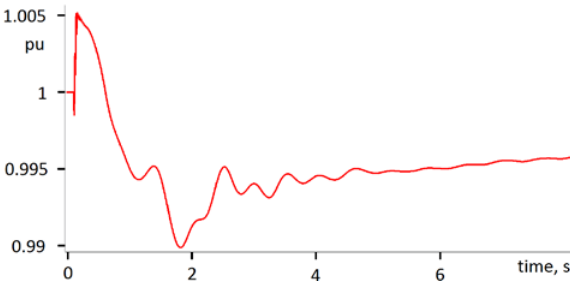
Fig. 10. Course of 4 G ω